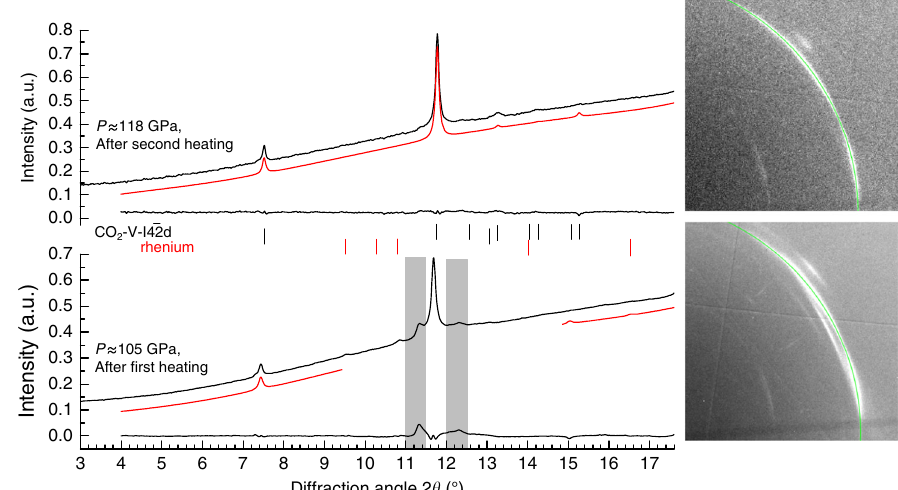
Fig. 2 Integrated X-ray diffraction patterns. The data are collected after the fi rst (bottom) and second (top) cycle of laser heating, with the temperature quenched to 295 K between the two cycles (Black lines — experimental data, red lines — calculated pro fi les; difference line at the bottom). The calculated peak positions for the CO 2 -V phase and rhenium lines are displayed as tick marks. Additional weak features of intensities in the pattern (as indicated by the gray area) can be attributed to intracrystalline strain gradients and orientation-dependent lattice deformation of differently oriented crystal grains and completely disappear after the second cycle of heating. The corresponding 2D diffraction images are shown at the right (112 peak position indicated with green